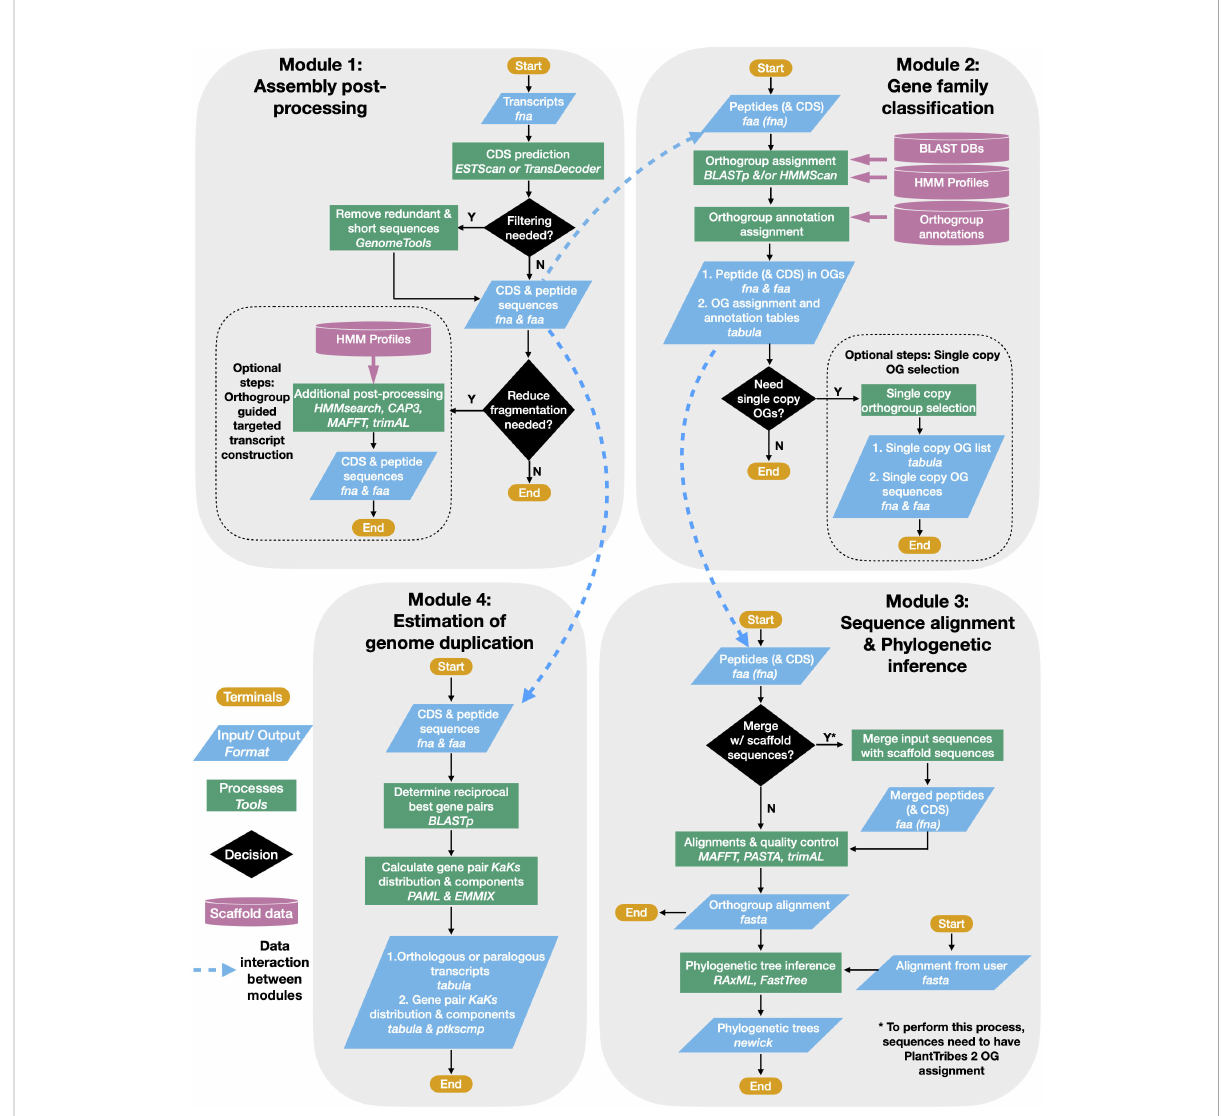
FIGURE 1 PlantTribes2 analysis work fl ow. A schematic diagram illustrating the PlantTribes2 modular analysis work fl ow. (1) A user provides transcripts for post-processing, resulting in a non-redundant set of predicted coding sequences and their corresponding translations (Module 1). (2) The post- processed transcripts (or user provided sequences) are searched against a gene family scaffold blast and/or hmm database(s), and transcripts are assigned into their putative orthogroups with corresponding metadata (Module 2). (3) Classi fi ed transcripts are integrated with their corresponding scaffold gene models to estimate orthogroup multiple sequence alignments and corresponding phylogenetic trees (Module 3). Similarly, sequence alignments and phylogeny can be constructed from user provided data. (4) Synonymous substitution rate (Ks) and nonsynonymous substitution rate (Ka) of paralogs from either the post-processed assembly or inferred from the phylogenetic trees are estimated. The Ks results are used to detect large-scale duplication events and many other evolutionary hypotheses (Module